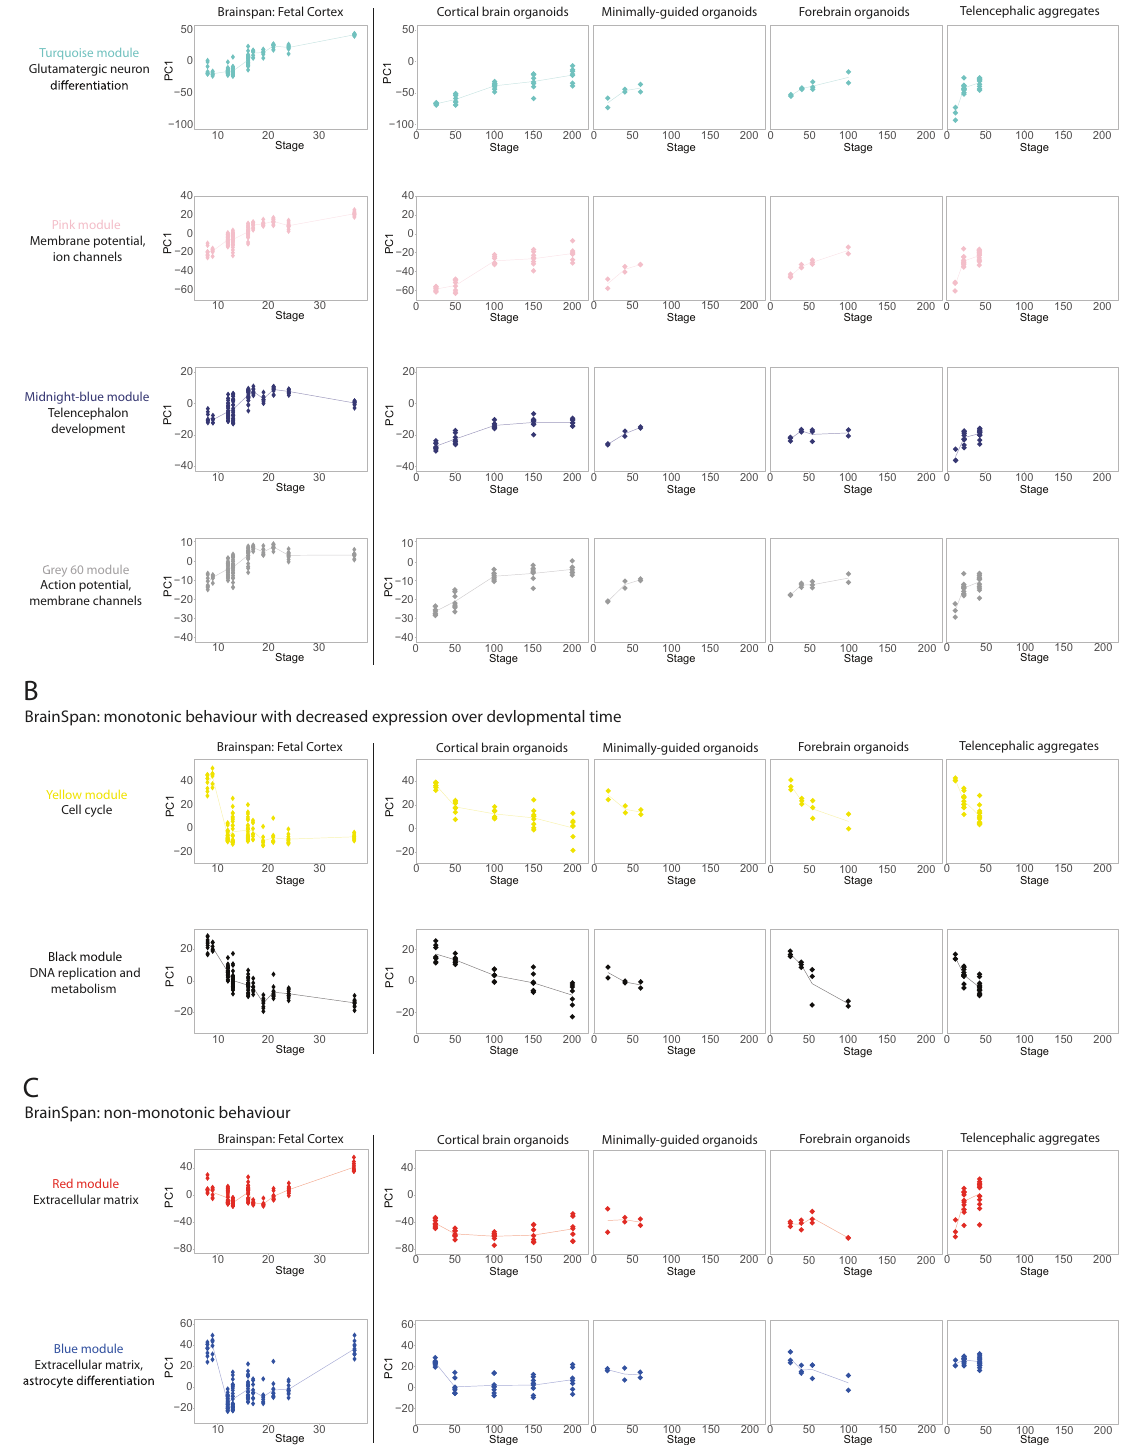
Fig. 6 Behavior of the module eigengene for BrainSpan gene co-expression patterns in BO. A Visualization of BS_Turquoise, BS_Pink, BS_Midnightblue, and BS_Grey60 in prenatal fetal cortex as well as in the BO datasets. PCA was performed to calculate the module eigengene on the BrainSpan and then applied to each BO dataset. Each dot represents a data point, while the line connects the median value for each post-conceptional week (BS) or differentiation day (BO). The same analysis and visualization was applied to BS modules with a decreased expression along development ( B ) or with a non-monotonic behavior ( C